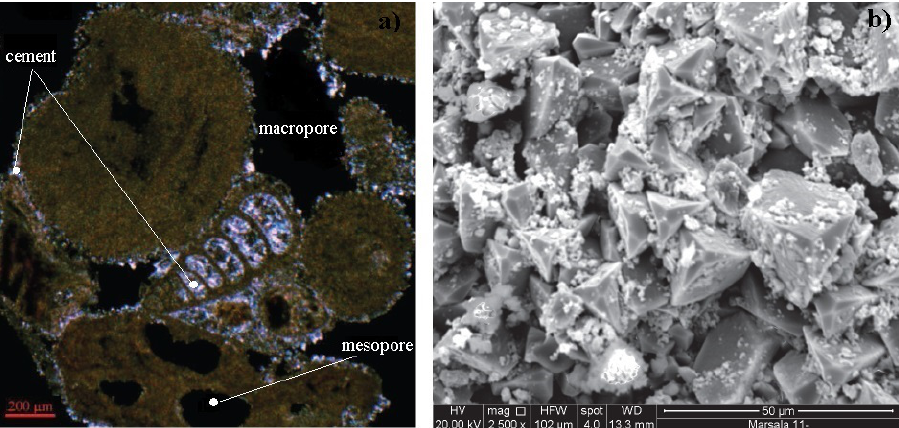
Figure 1. Natural lithotype B2: ( a ) Thin section; ( b ) Environmental scanning electron microscopy image.